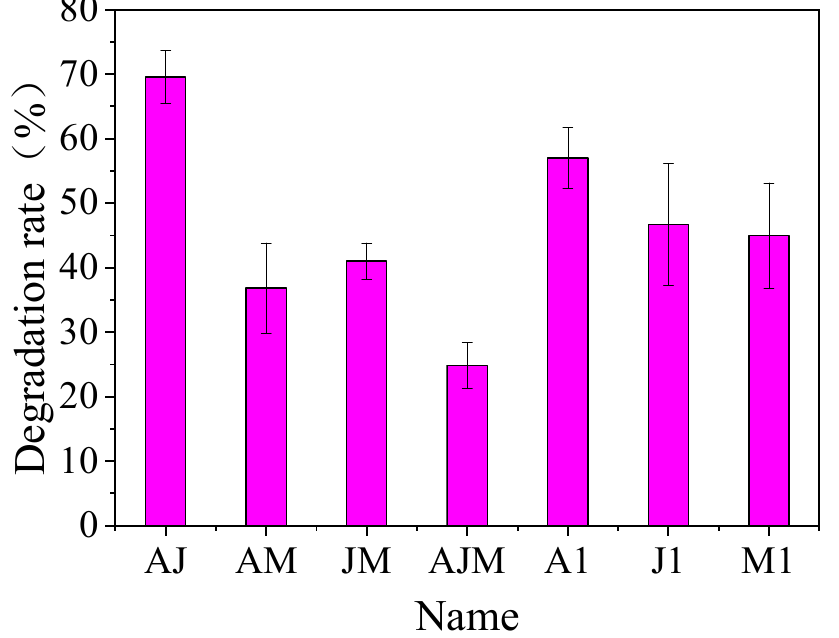
Figure 4. Degradation ability of compound bacterial agents to β -HCH (AJ indicates a mixture composed of strains A1 and J1 in equal proportions, and the same for AM, JM, and AJM).